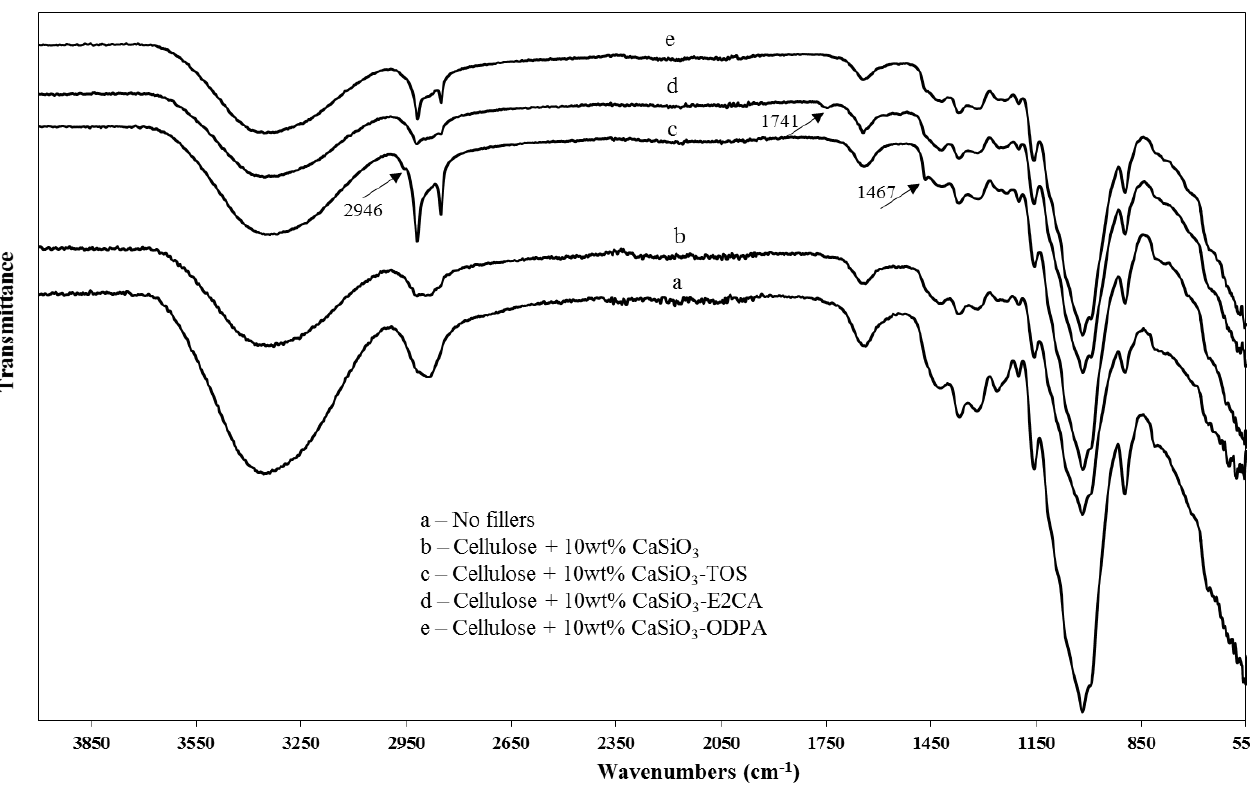
Figure 1. ATR-FTIR of ( a ) cellulose with no fillers, ( b ) cellulose-10 wt% CaSiO 3 composite, ( c ) cellulose-10 wt%CaSiO 3 composite–TOS coated, ( d ) cellulose-10 wt% CaSiO 3 composite–E2CA coated and ( e ) cellulose-10 wt% CaSiO 3 composite– ODPA coated.